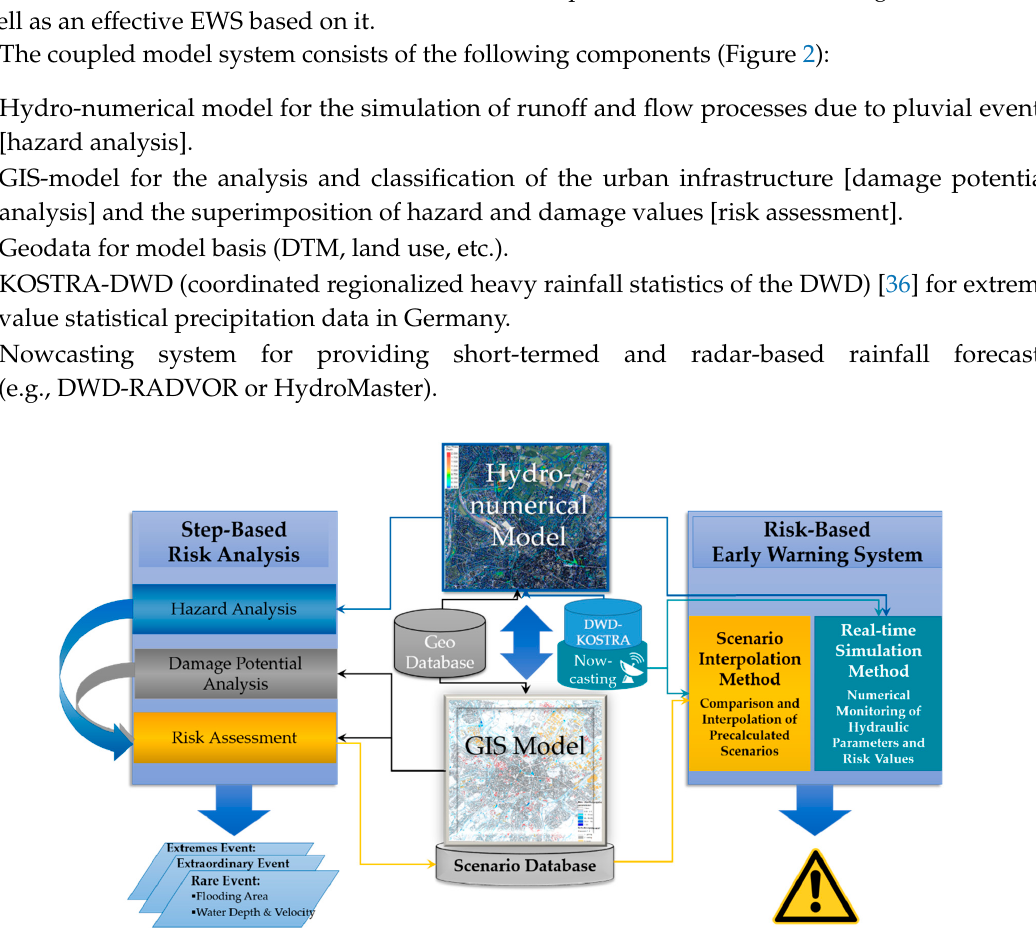
Figure 2. Architecture and key elements of the Multifunctional Pluvial Flood Information System [35]. In the coupled-model system, the hydro-numerical model performs the hydrodynamic modeling of rainfall runoff processes. The model used the fully dynamic hydraulic and hydrologic